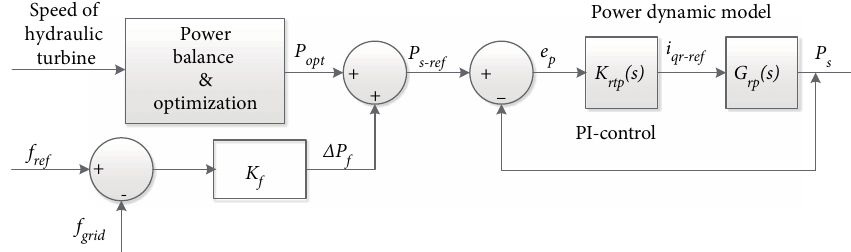
Figure 10: Droop-based direct power vector control structure for RSC of the VSPS (active power control loop).